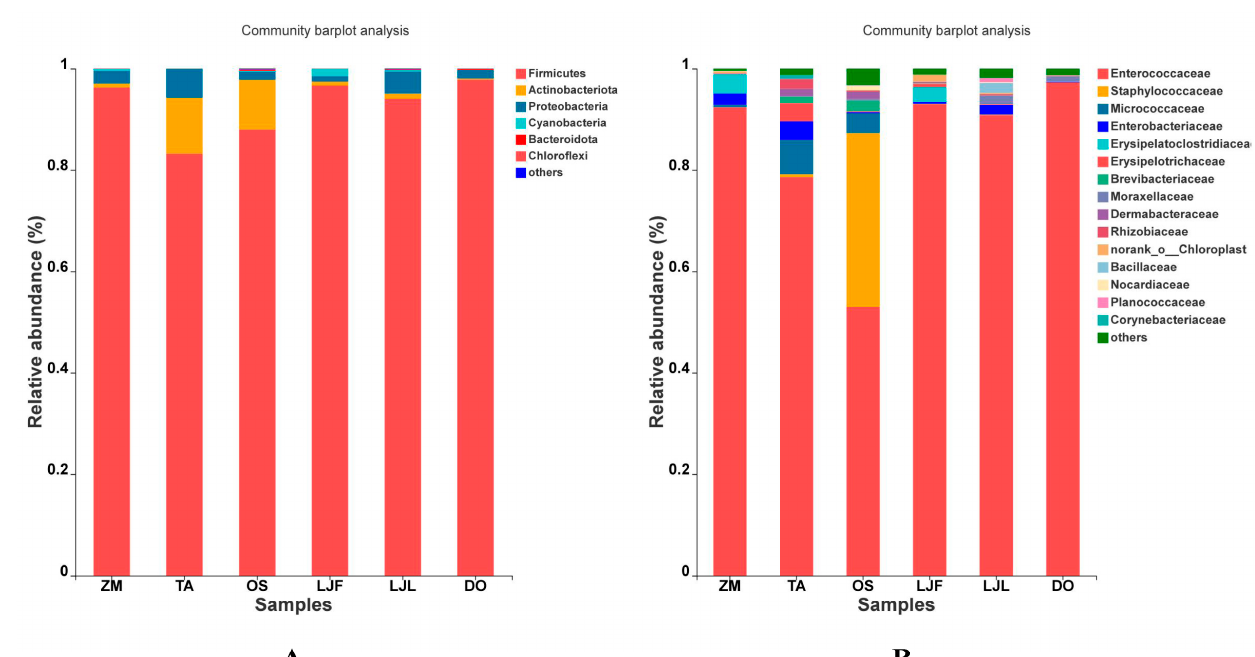
Abbreviations in the table represent different treatments: ZM, maize; TA, wheat; OS, rice; LJF, honeysuckle flowers; LJL, honeysuckle leaves; and DO, Chinese yam. The data are the mean ± SE. The letters indicate the significant differences in relative abundance in the same taxon between different treatment groups (one-way ANOVA, Tukey’s test, α = 0.05).